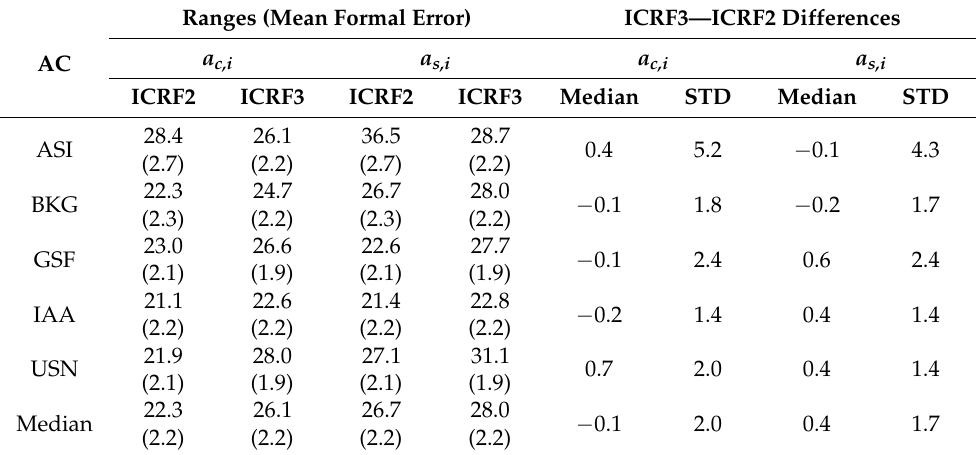
Table 3. Test A: statistics of the corrections to the main lunisolar nutation terms (units: µ as). Ranges (Mean Formal AC